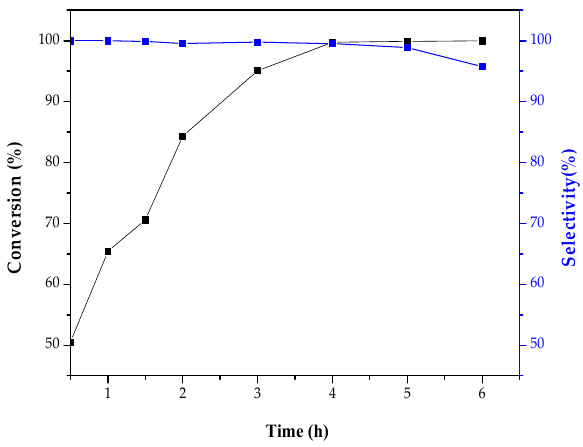
Figure 6. Impact of reaction time on the conversion (black) and selectivity (blue) in the selective hydrogenation of p ‐ CNB. Reaction conditions: 1 g 0.27 wt % modified Pd/ γ ‐ Al 2 O 3 @ASMA treated with 100 g/L morpholine, 1 g p ‐ CNB dissolved in 50 mL ethanol, 80 °C, 600 rpm, and 2 MPa H 2 pressure in a 100 mL autoclave.